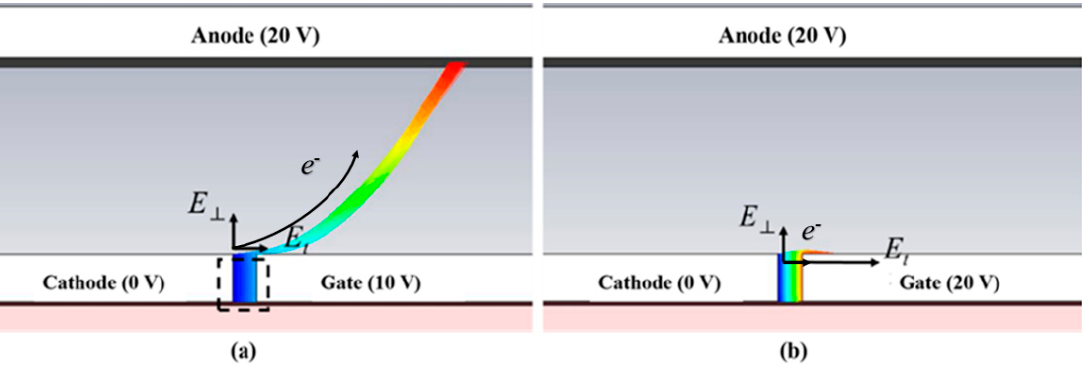
Figure 3. Top view of the electron trajectory of the NVC electron source at different gate voltages. ( a ) 10 V. ( b ) 20 V.